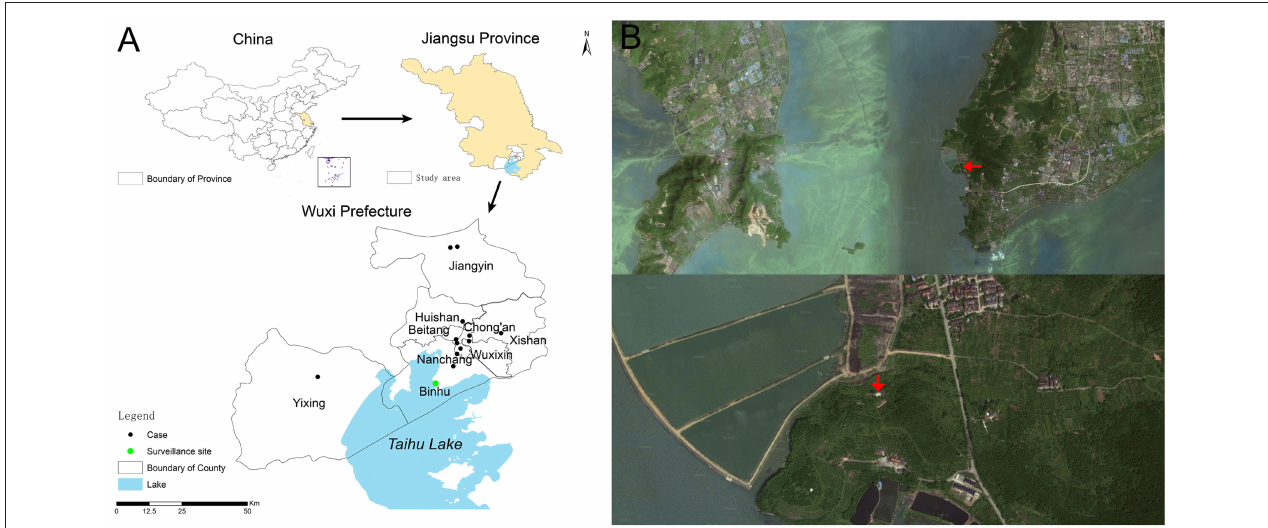
FIGURE 1 | Sentinel surveillance study site, Wuxi City, Jiangsu Province of China. (A) Location of surveillance study site and distribution of human infections with influenza A (H7N9) virus; (B) Satellite map of study site, red arrows indicate study